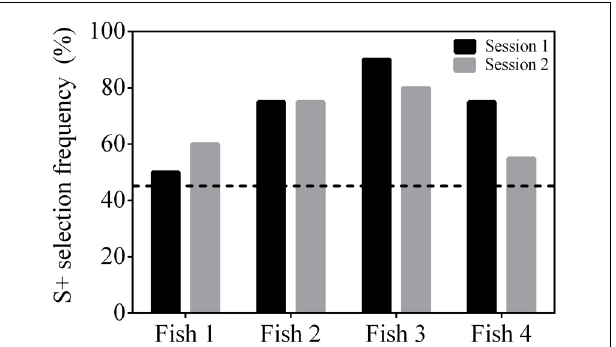
FIGURE 7 | Selection frequency (%) of S + using a 4-AFC test where all three conditioned stimulus pairs were presented within a session. The results of two testing sessions ( n = 20 trails each) are presented for four subjects.The dashed line at 45% indicates a statistically significant selection frequency of S + . All subjects achieved an S + selection frequency above